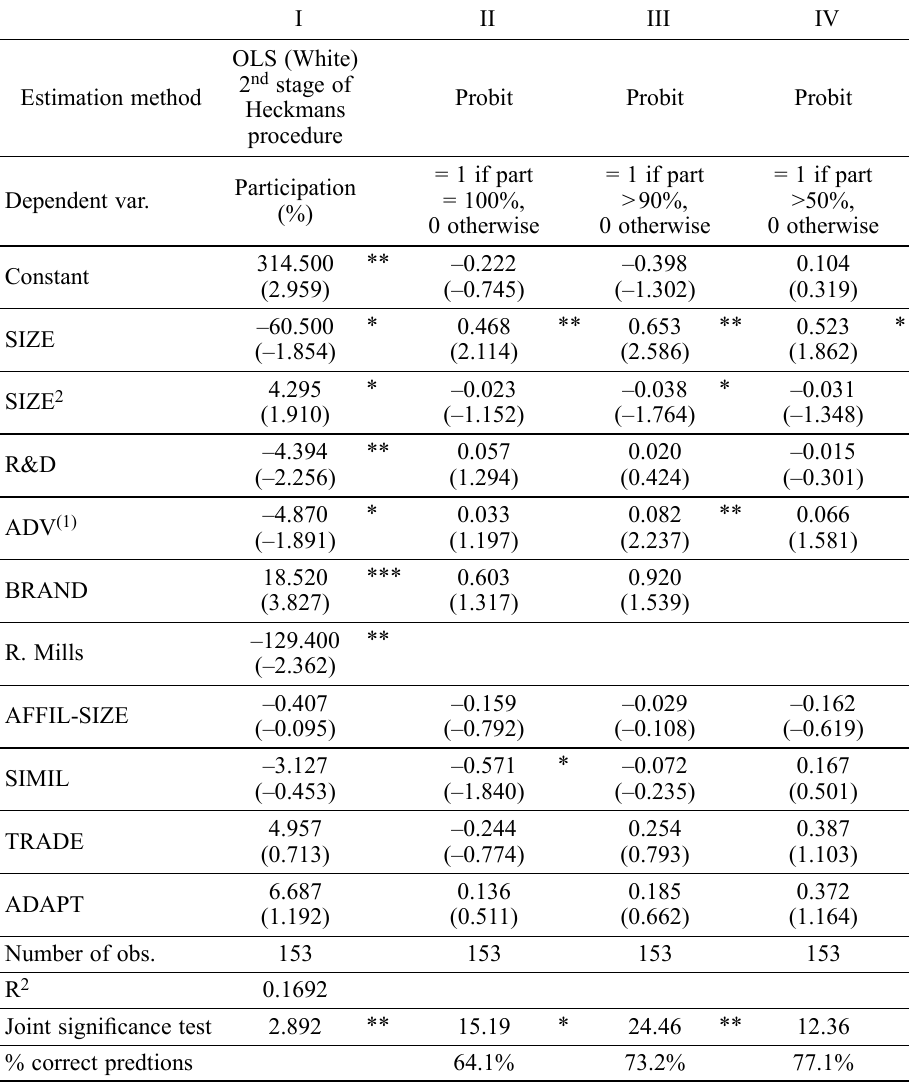
Table 4. Estimation of different models for the participation on equity of main subsidiary I